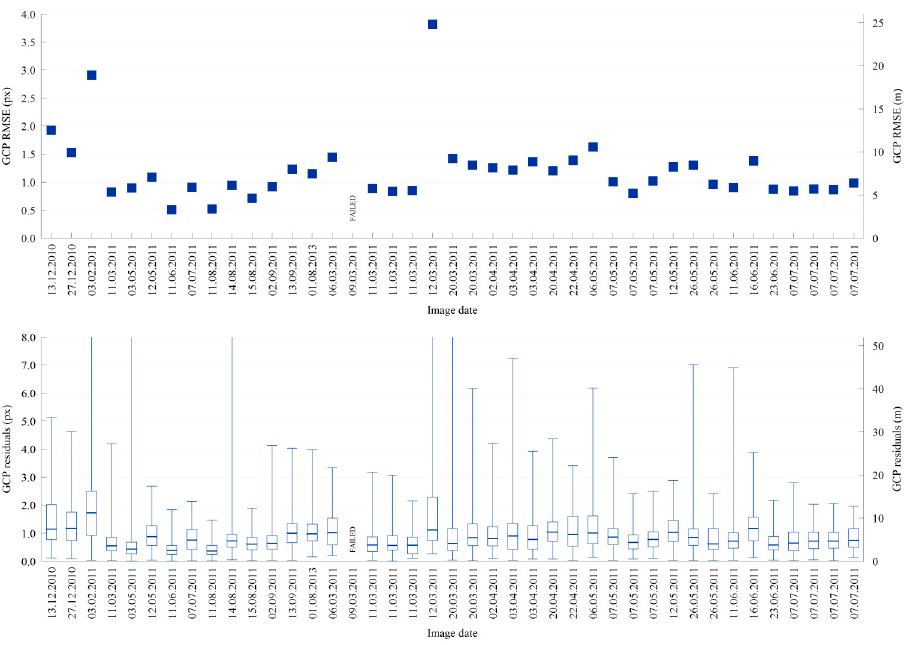
Figure 9. Root-mean-square error (RMSE) in pixels/meters at extracted GCPs per image ( above ) and boxplots of corresponding GCP residuals per image ( below ) for 41 RapidEye 1B images. Note: Images with the same acquisition date were acquired on the same satellite pass, however they have a different imaged area (RMSEs for such images are very similar).